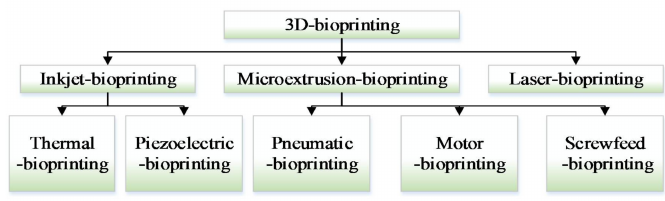
Figure 1. Three-dimensional (3D) bioprinter classification.